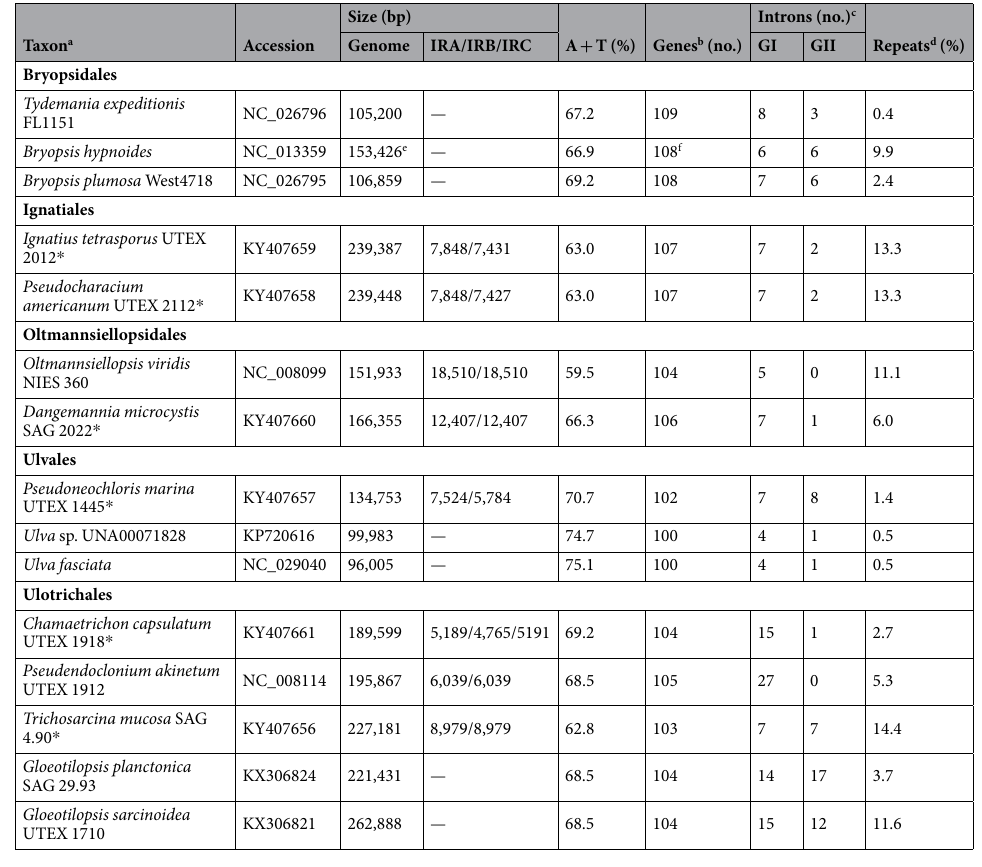
Table 1. General features of ulvophycean chloroplast genomes. a The taxa newly examined in this study are denoted by asterisks. b Intron-encoded genes and freestanding ORFs not usually found in green plant chloroplast genomes were not considered. Duplicated genes were counted only once. c Numbers of group I (GI) and group II (GII) introns are given. d Nonoverlapping repeat elements were mapped on each genome with RepeatMasker using as input sequences the repeats of at least 30 bp identified with REPuter. e This value is based on the re- annotated version of Leliaert & Lopez-Bautista 35 . f This value includes four genes with frameshift mutations ( rpoB , rpoC1 , ycf20 and ycf47